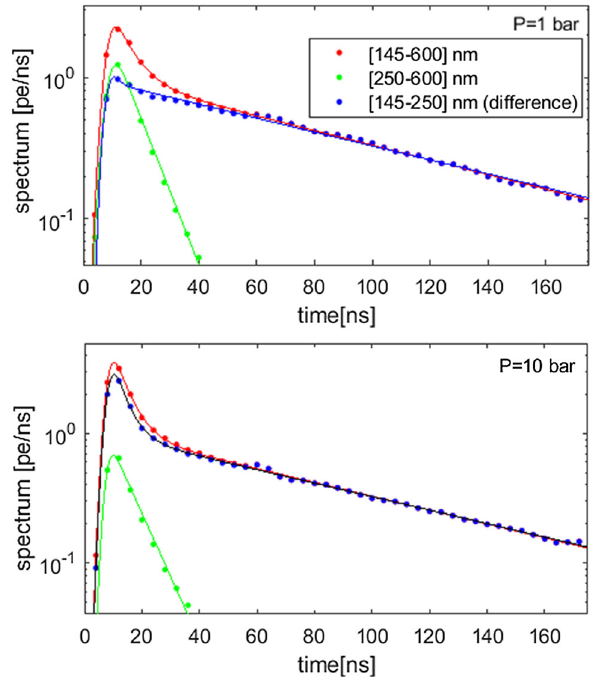
Fig. 14 Average time spectra for the primary scintillation (S1) of α - particles in high electric field conditions (above 50 V/cm/bar, i.e., no charge recombination). The directly measured spectra (red for 145– 600 nm and green for 250–600 nm) have been subtracted to obtain the uncontaminated 2nd continuum signal (blue). Top: 1 bar. Bottom: 10 bar. Fits to Eq. (4) have been included with continuous